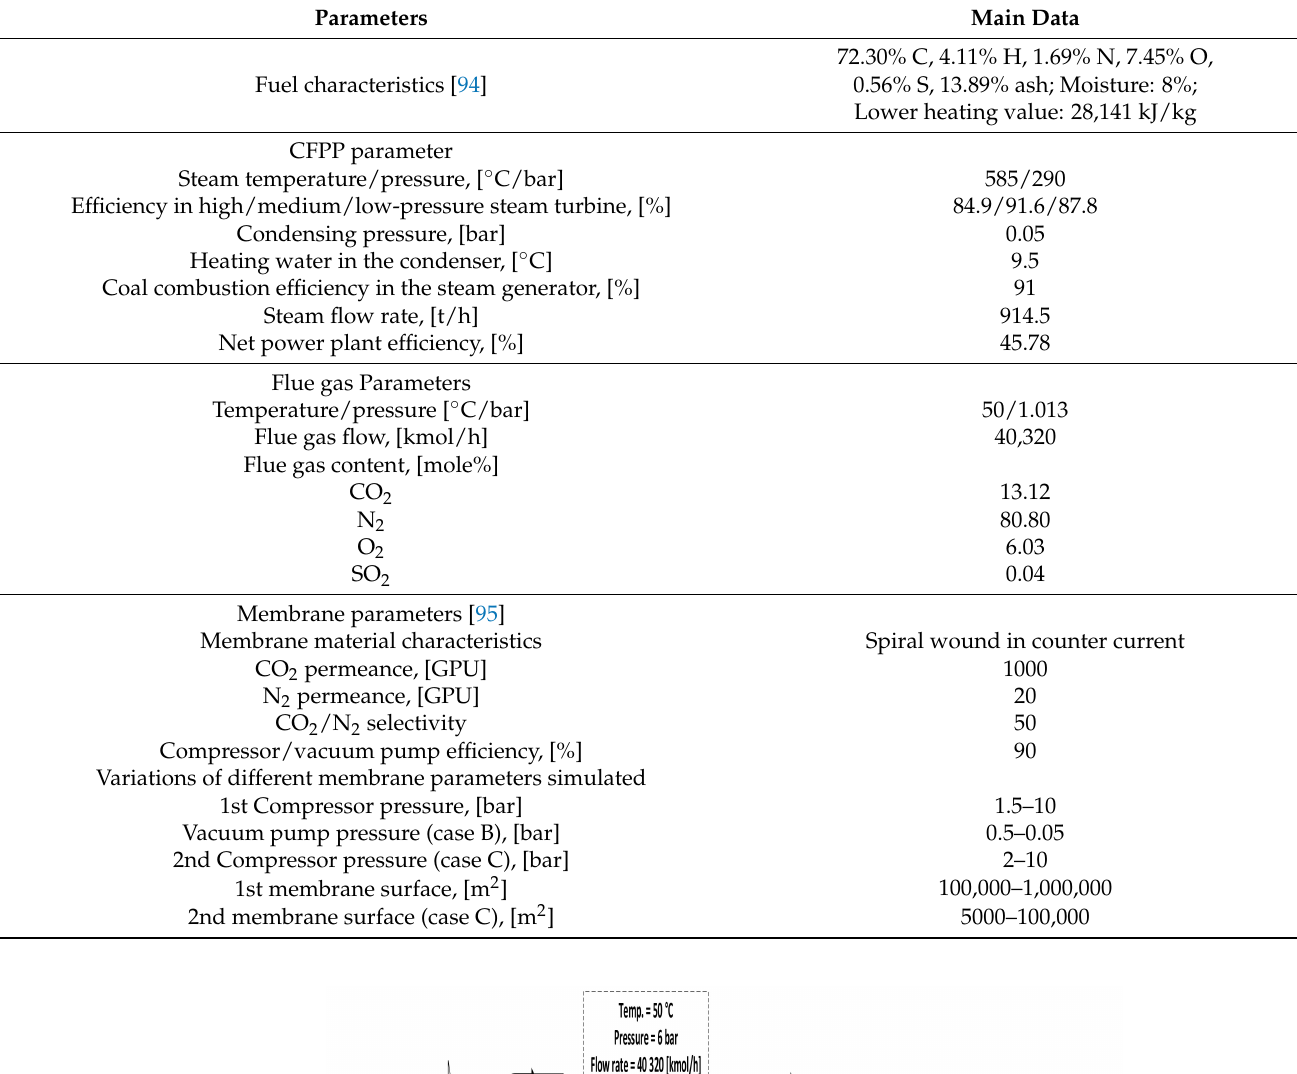
Table 7. The main parameters of CFPP and membrane.